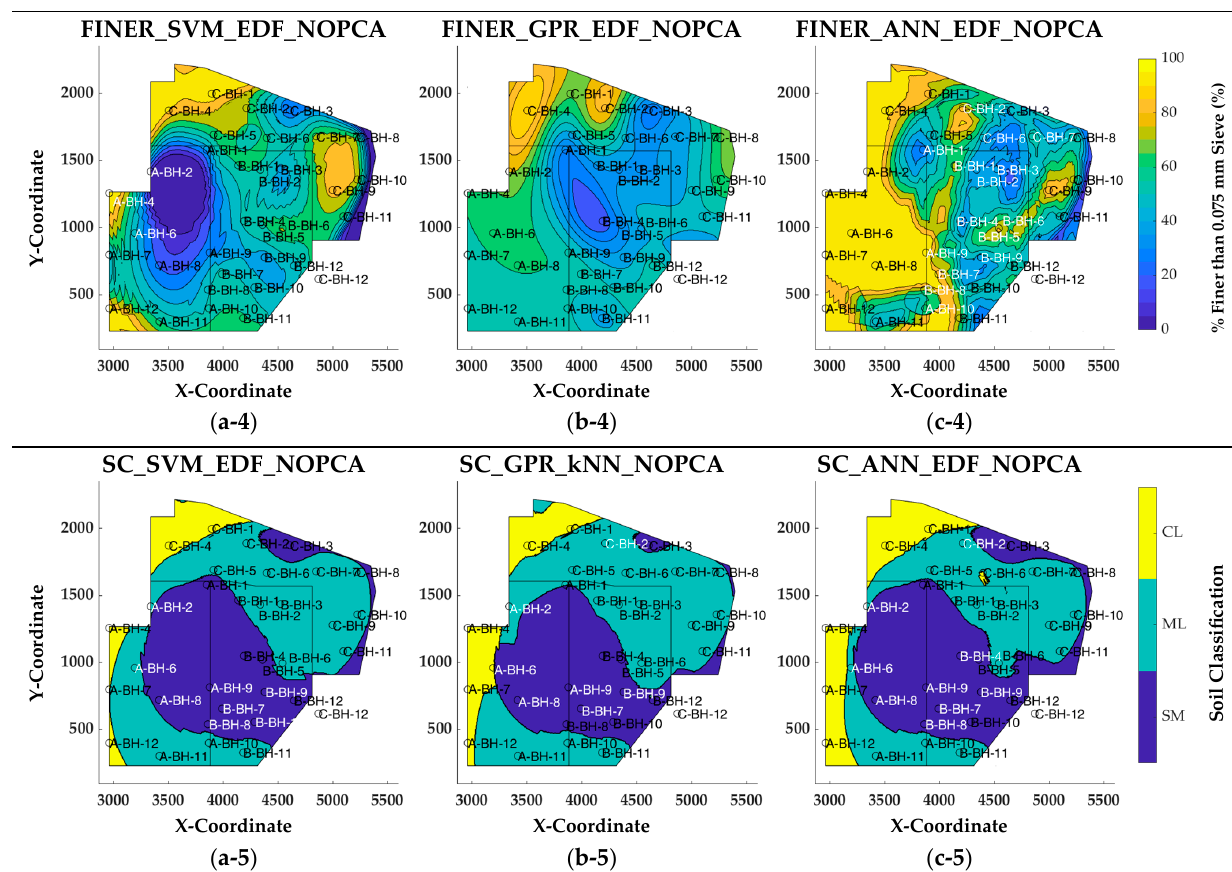
Figure 13. Top view of predicted value: ( a-1 – c-1 ) ground surface elevation; ( a-2 – c-2 ) groundwater level; ( a-3 – c-3 ) SPT-N value at elevation 0 m ( top ) and − 3 m ( bottom ); ( a-4 – c-4 ) percent finer than 0.075 mm sieve at elevation − 4 m; and ( a-5 – c-5 ) soil classification at elevation 0 m, where one unit in X and Y coordinate equal 1 m (1 unit = 1 m).